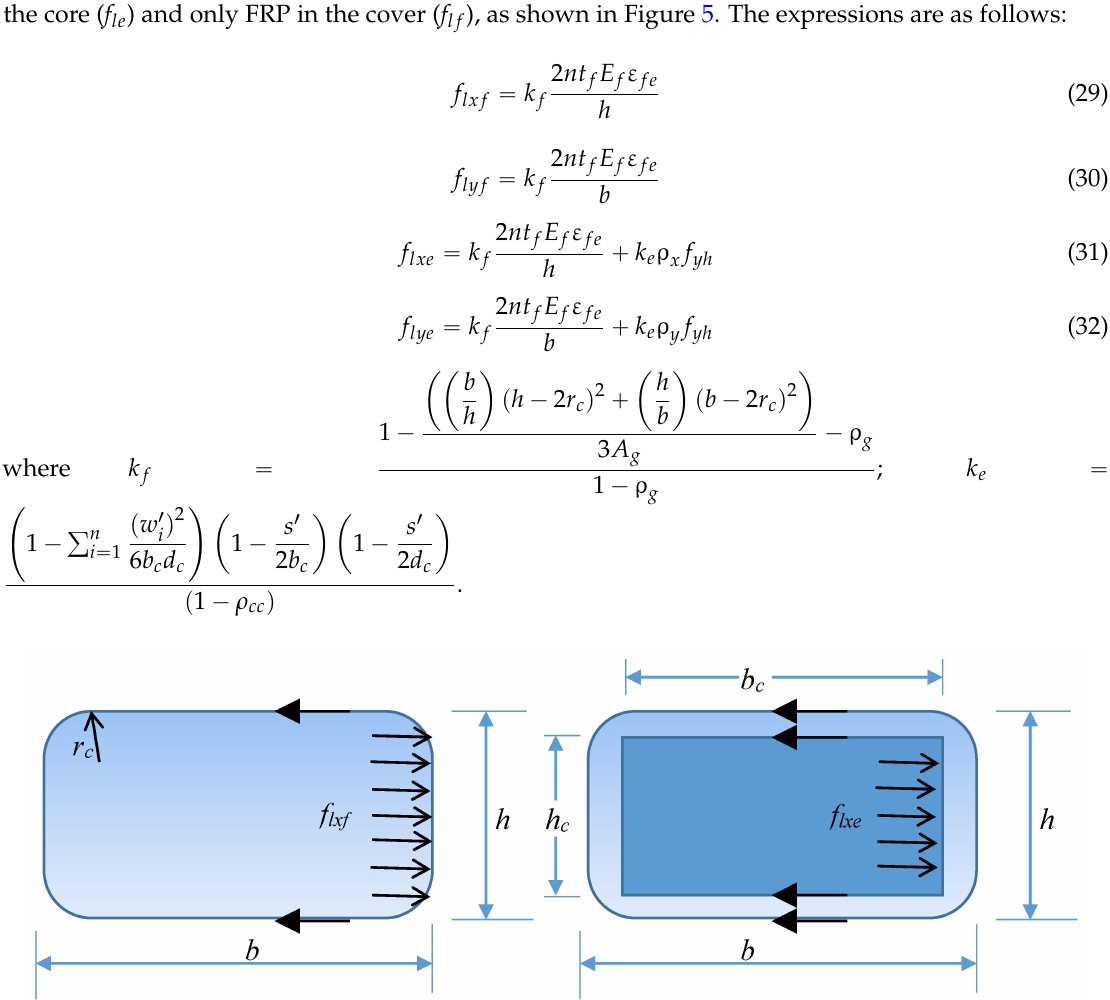
Figure 5. Effective Horizontal pressure of the confined rectangular